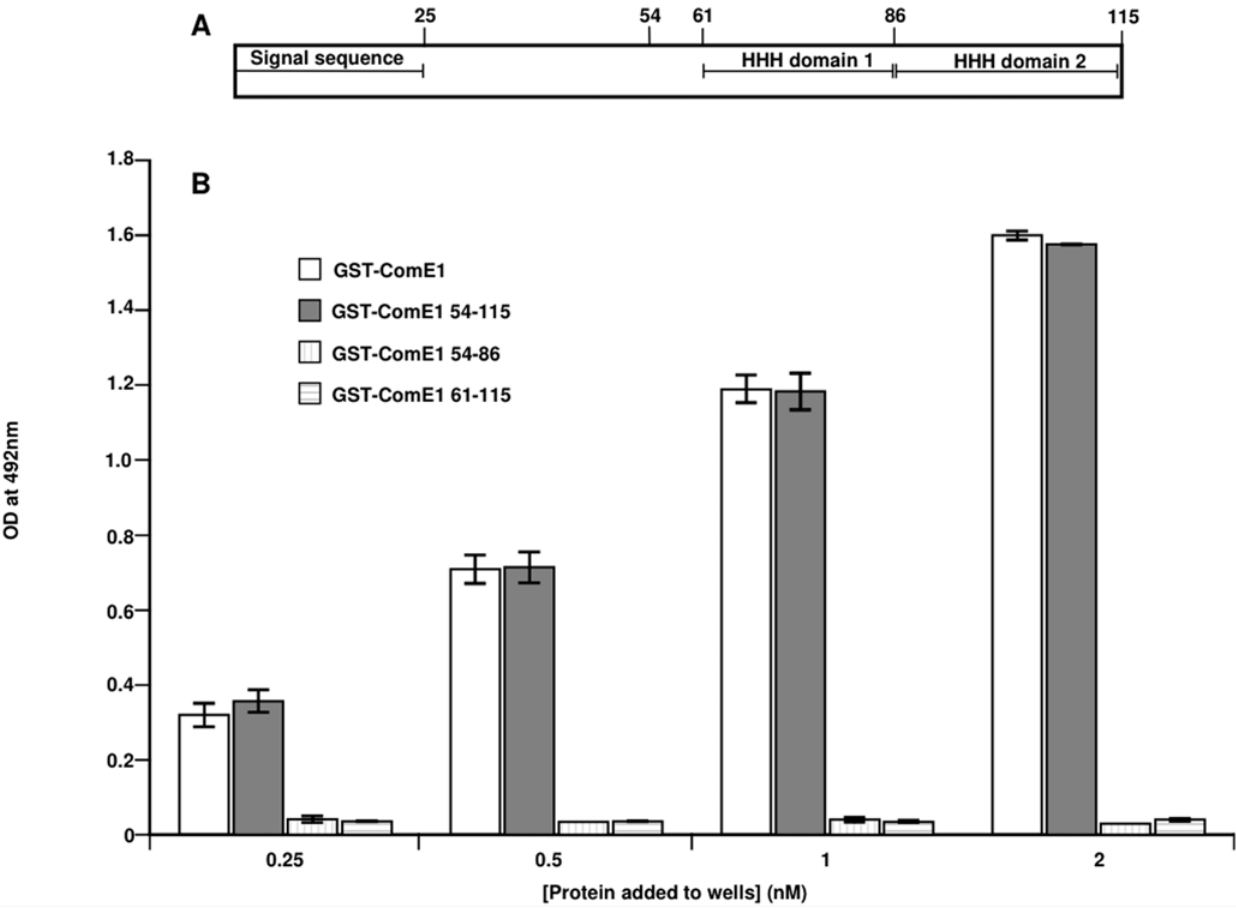
Figure 5. Schematic representation of the structural features of ComE1 (A). Binding of fragments of ComE1 from P. multocida (expressed as GST fusion proteins) to pUC19 DNA measured by direct binding ELISA (B). Increasing concentrations of rGST-ComE1 (open circles), the C-terminal 64 residues of ComE1 (closed circles), the two HHH domains of ComE1 (closed triangles) or a combination of the conserved VNINTA motif plus the first HHH domain (open triangles), were added to wells coated with Fn. Optical density values at 492 nm were converted to estimates of the concentration of bound protein by reference to a standard curve for each protein.